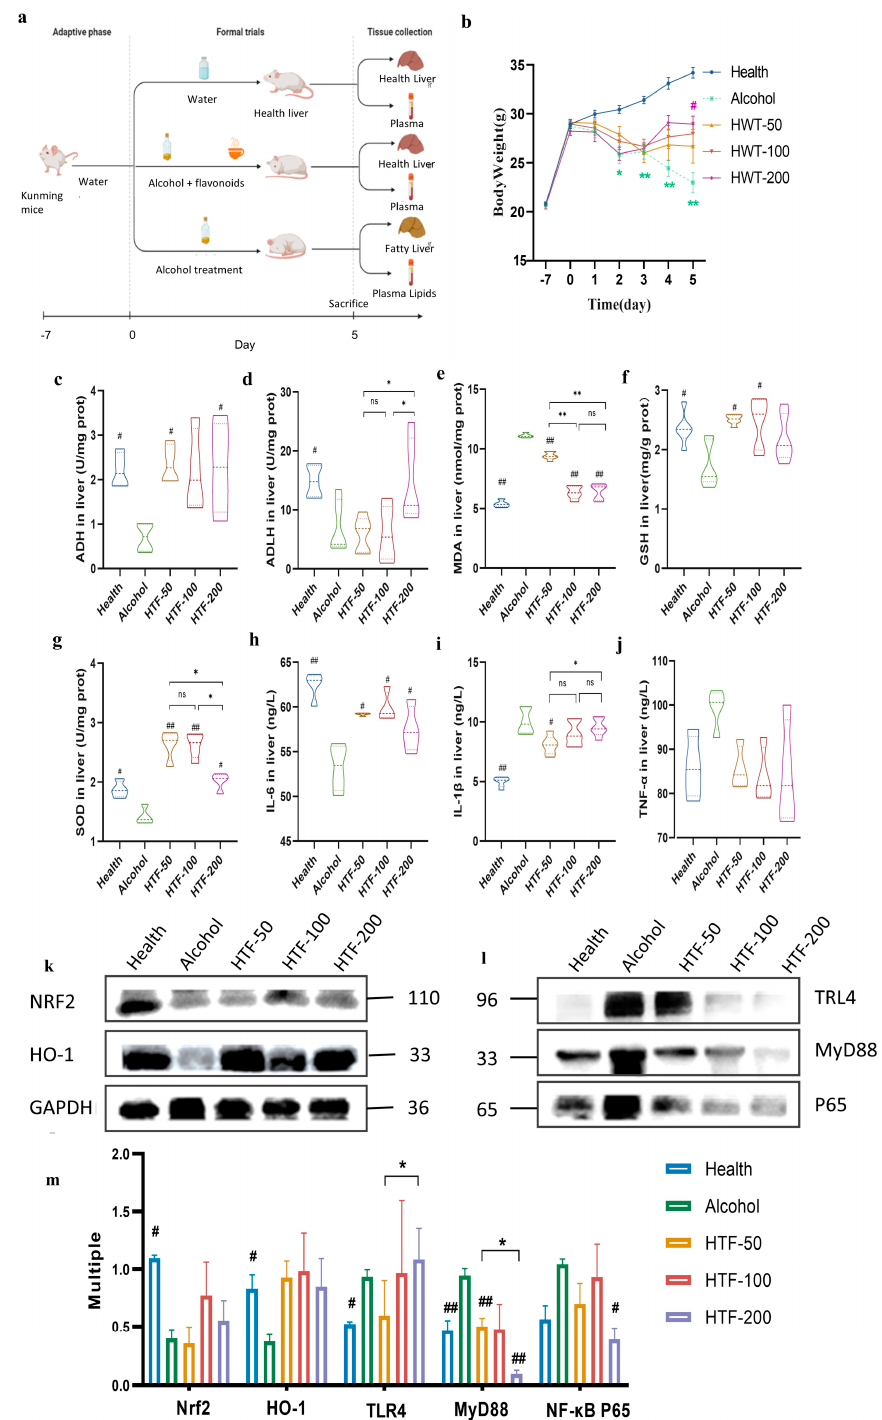
Figure 2. HTF reduced alcohol-induced oxidative stress and inflammatory response in acute ALD- model mice. ( a ) The experimental group. ( b )Body weight. ( c ) Level of ADH. ( d ) Level of ALDH. ( e ) Level of MDA. ( f ) Level of GSH. ( g ) Level of SOD. ( h ) Level of interleukin-6 (IL-6). ( i ) Level of interleukin-1(IL-1 β ). ( j ) Level of TNF- α . ( k ) Western blot. ( l ) Western blot. ( m ) Western blot analysis ( n = 3 per group). Data are mean ± SEM. Significance was determined by one-way ANOVA corrected for multiple comparisons with Dunnett’s test. # p < 0.05 and ## p < 0.01 compared with Alcohol group. ns, p > 0.05, * p < 0.05 and ** p < 0.01 compared with other HTF